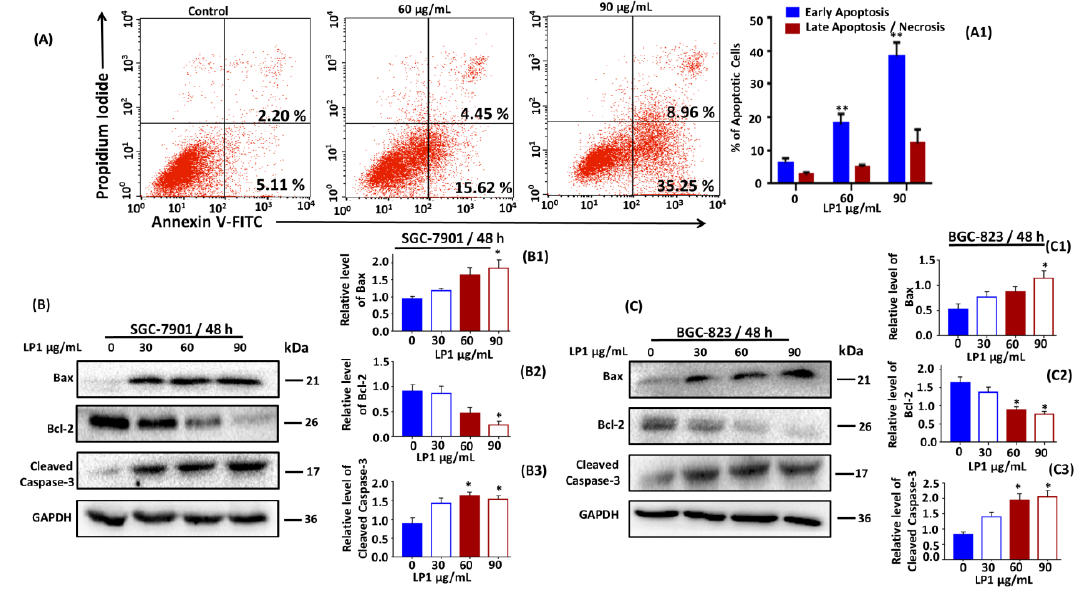
Figure 5. Induction of apoptosis and inhibition of PI3K/Akt/mTOR by LP1 in SGC-7901 cells. ( A ) SGC-7901 cells were treated with (0, 60, 90 µ g/mL) and without LP1 for 48 h to analyze apoptosis by Annexin-V/PI staining. Numbers within the quadrant represent the percentage of cells (Annexin V+/PI − , lower right) and (Annexin V+/PI+, upper right). ( A1 ) A number of apoptotic populations were counted. Results are expressed as means ± SD (** p < 0.01) of three independent experiments; ( B ) expression level of Bax, Bcl-2 and cleaved caspase-3 in SGC-7901 cells treated with various concentration (0, 30, 60, 90 µ g/mL) of LP1 for 48 h were analyzed by western blot assay, GAPDH was used as an internal control. ( B1 – B3 ) Western blots were quantified by densitometry and results are expressed as means ± SD (* p < 0.05) of three independent experiments. ( C ) Expression level of Bax, Bcl-2 and cleaved caspase-3 in BGC-823 cells treated with various concentration (0, 30, 60, 90 µ g/mL) of LP1 for 48 h were analyzed by western blot assay, GAPDH was used as an internal control. ( C1 – C3 ) Western blots were quantified by densitometry and results are expressed as means ± SD (* p < 0.05) of three independent experiments.